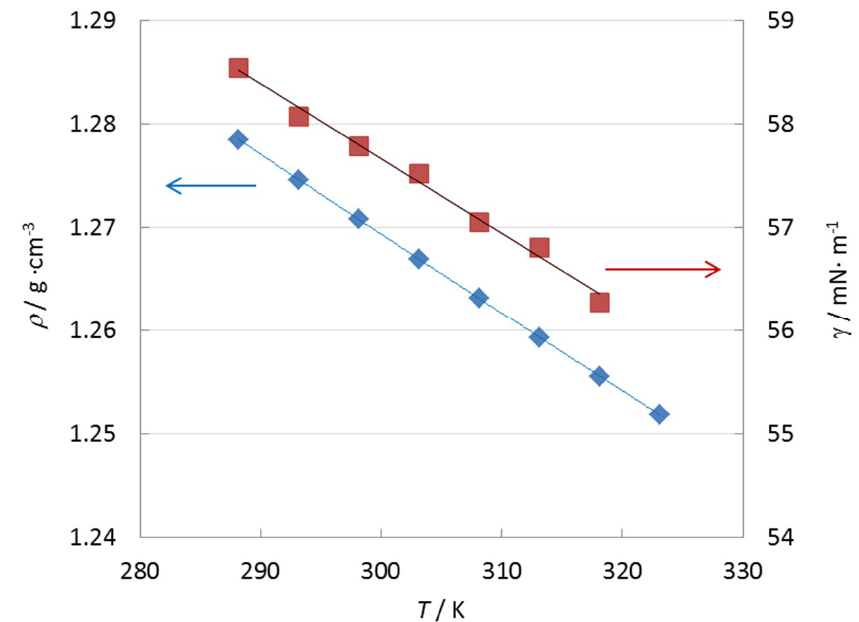
Figure 4. Density (blue squares/line) and surface tension (red squares/line) of (EMIm) 2 [Mn(NCS) 4 ] (sample I) at different temperatures T.